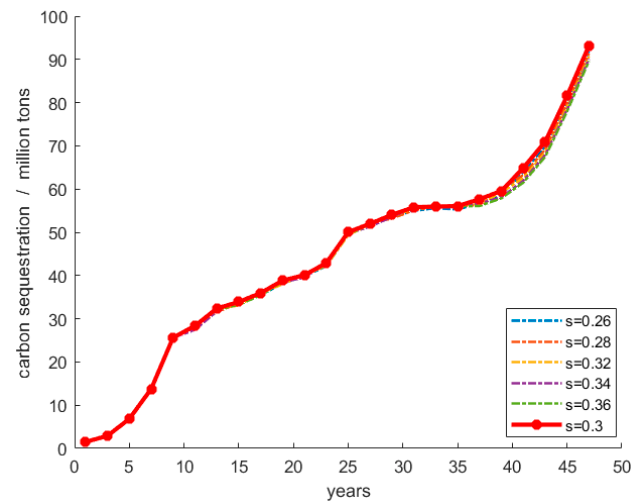
Figure 6. Sensitivity analysis of the forest product loss rate S .